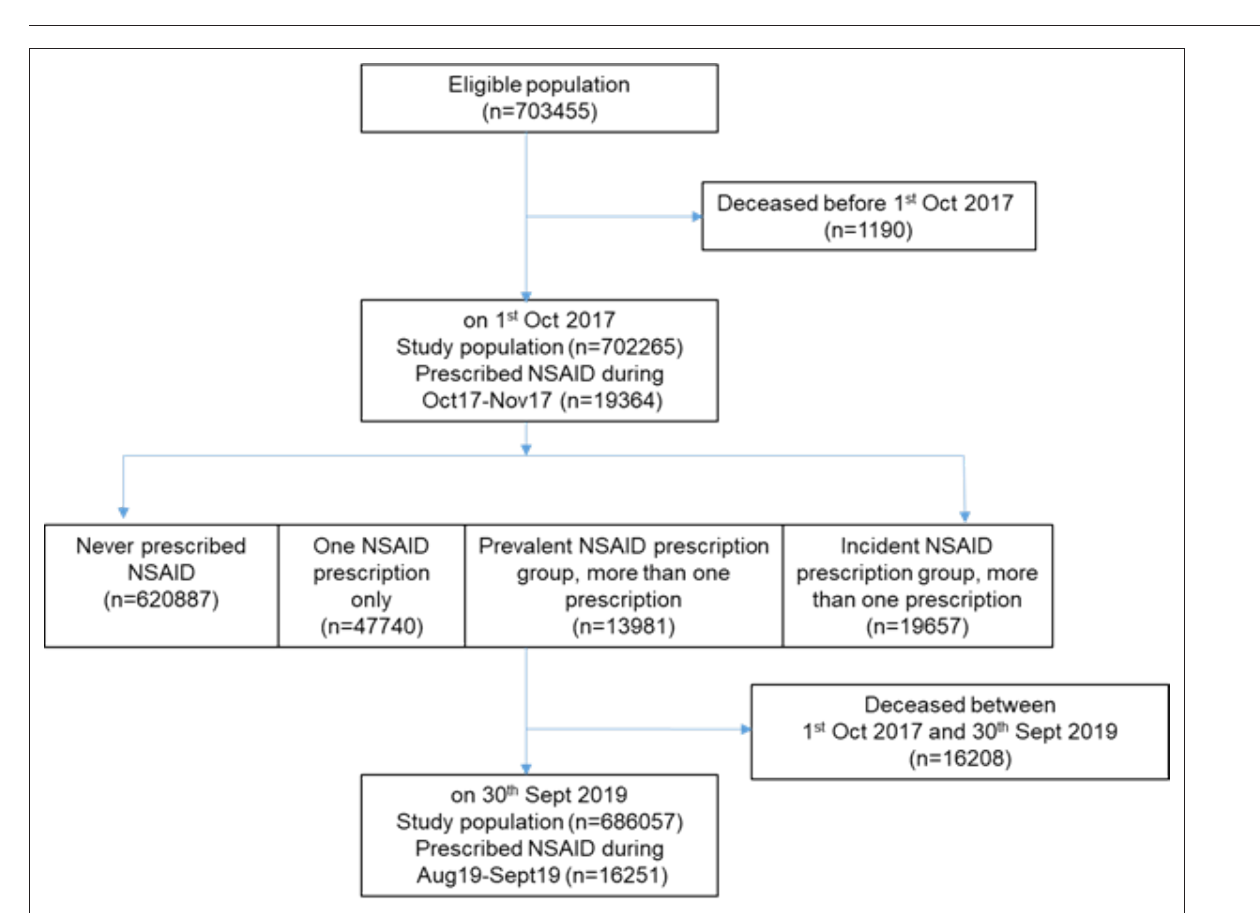
Figure 1 Flow diagram of study participants. NSAID = non- steroidal anti- inflammatory